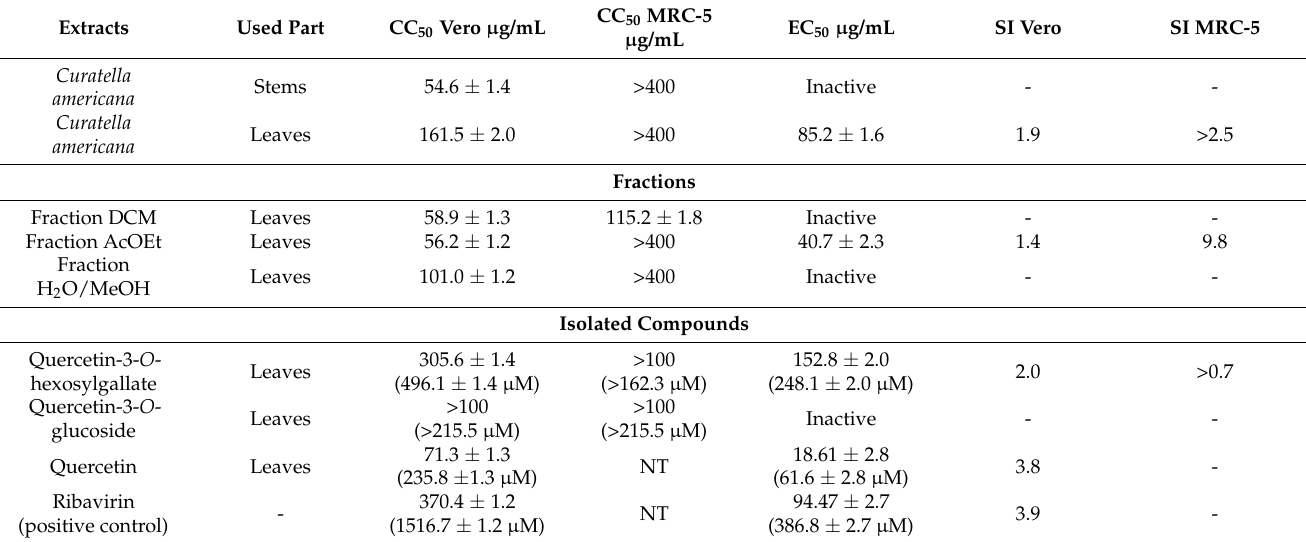
Table 2. Anti–Zika virus activity and its standard deviations ( n = 3) of ethanolic extracts of stems and leaves, fractions, substances isolated from Curatella americana